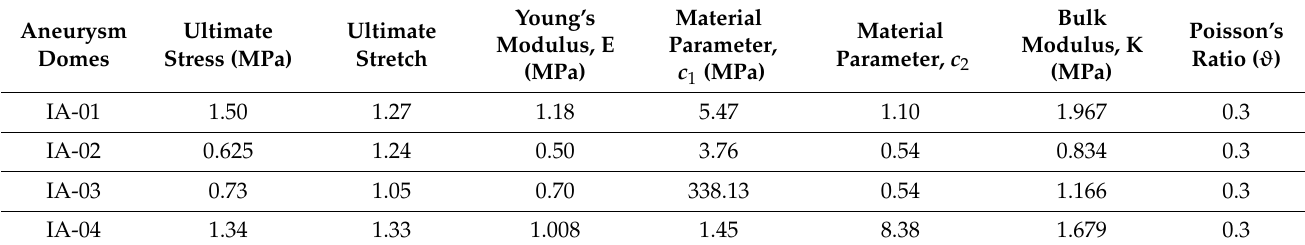
Table 2. Mechanical parameters of the unruptured intracranial aneurysms